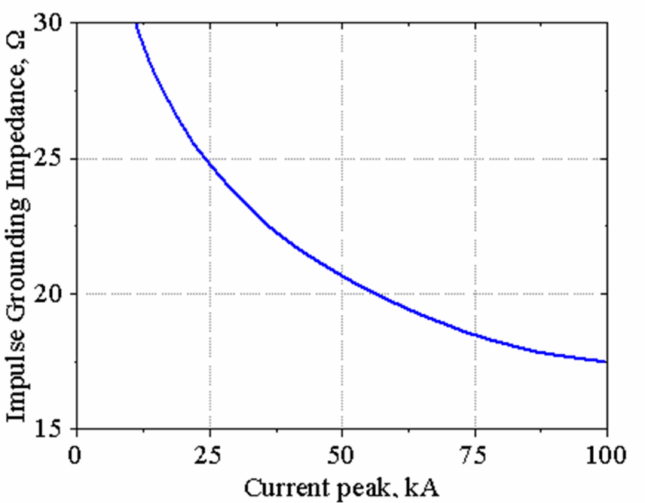
Figure 7. Influence of the current peak on the impulse grounding impedance of a vertical rod of 10 m, soil resistivity of 500 Ω m, critical electric field of 10 kV/cm and current waveform of 1/200 µ s.